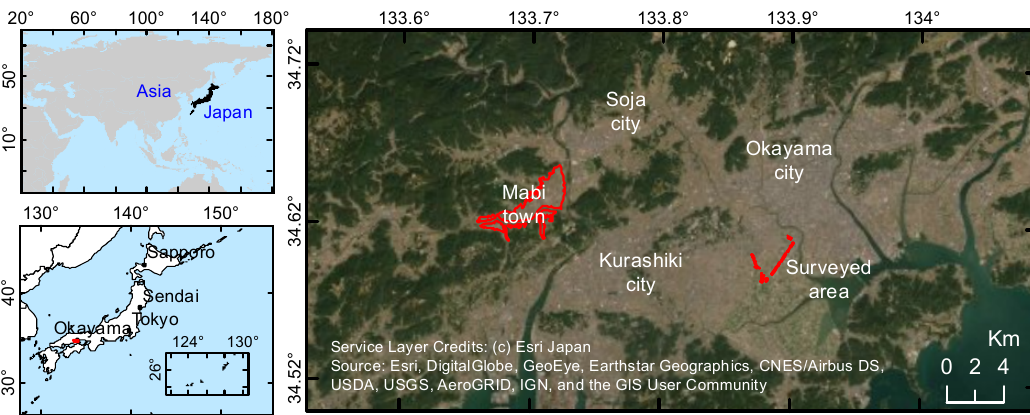
Figure 1. Geographical location of the study area. The polygons at Mabi town denotes the estimated flooded area provided by Geospatial Information Authority of Japan (GSI). The polygons labeled as surveyed area denotes the paddy fields that were